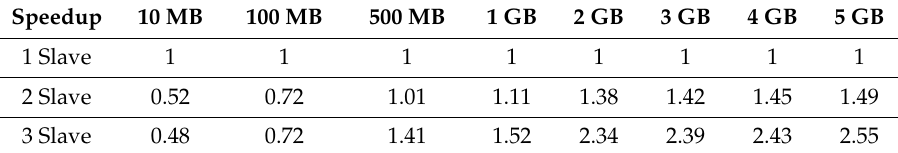
Table 13. The speedup of fault diagnosis under different node numbers.